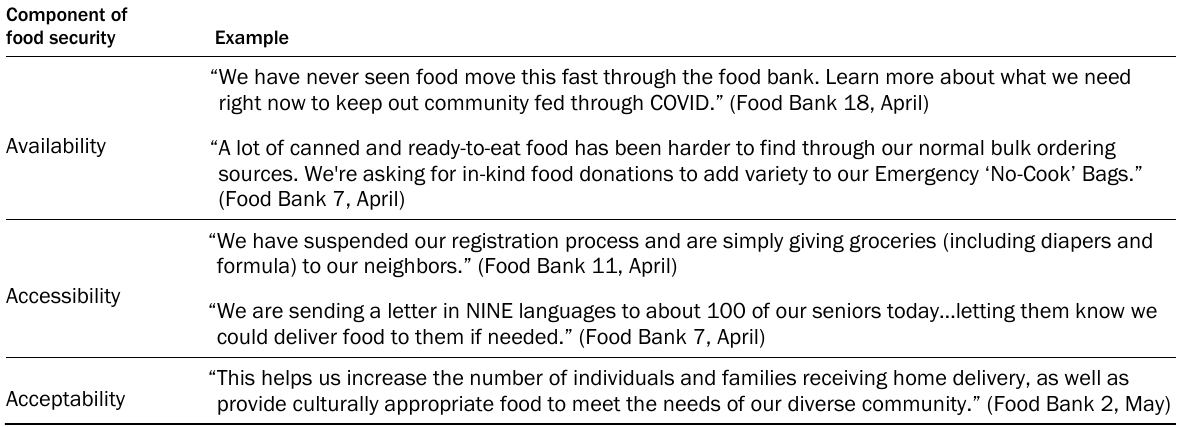
Table 7. Examples from Social Media Posts Component of food